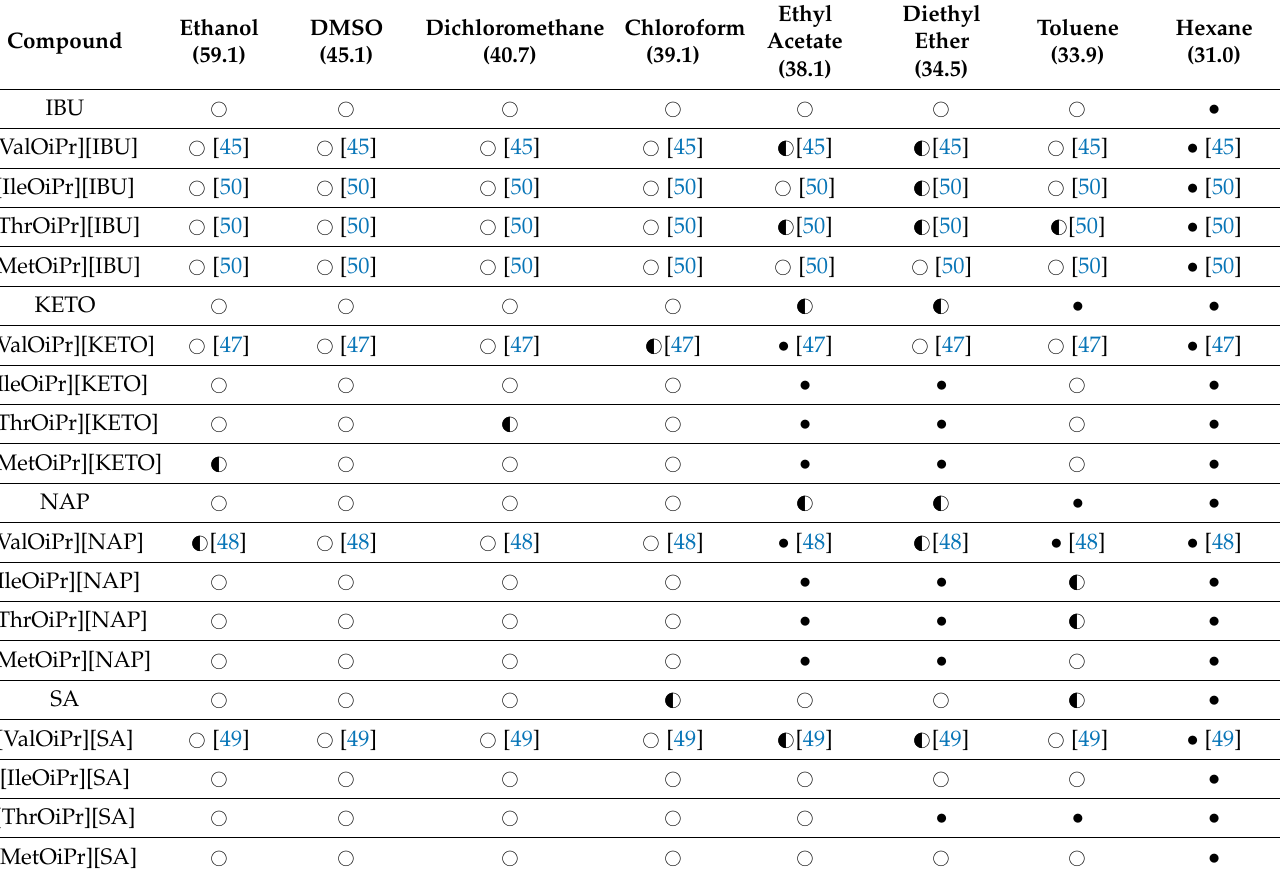
Table 2. Solubility of NSAIDs and their amino acid isopropyl esters salts in organic